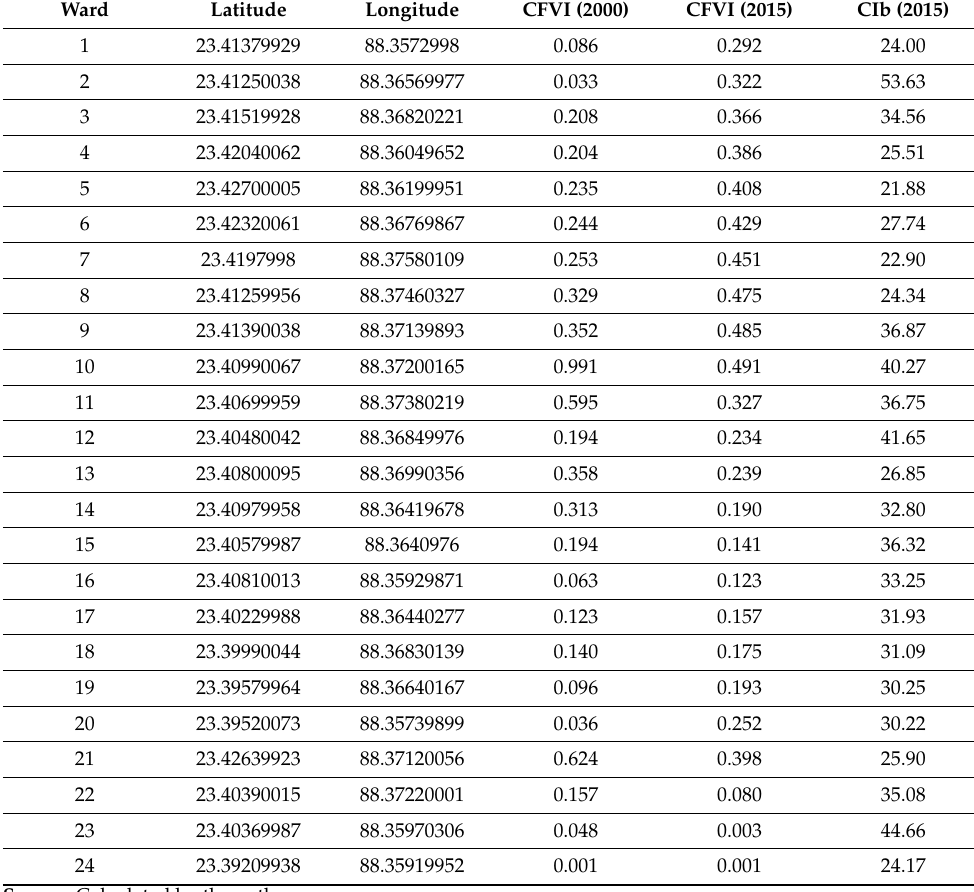
Table 14. Composite flood vulnerability index (CFVI) (2000 and 2015) and composite Ibrahim index (CIb) (2015) of the wards of Nabadwip Municipality.